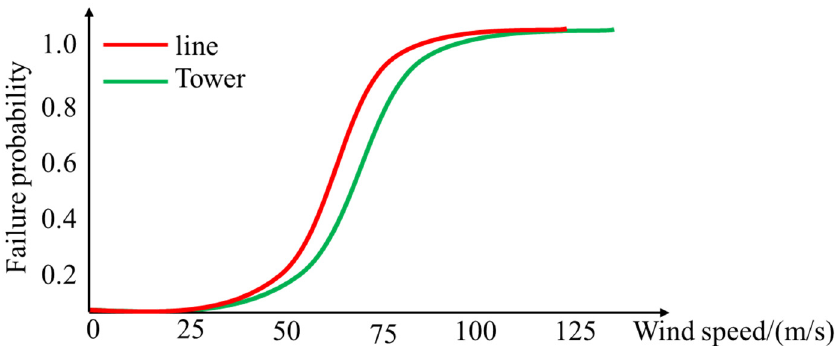
Figure 2. Typical component failure probability curves in distribution network.